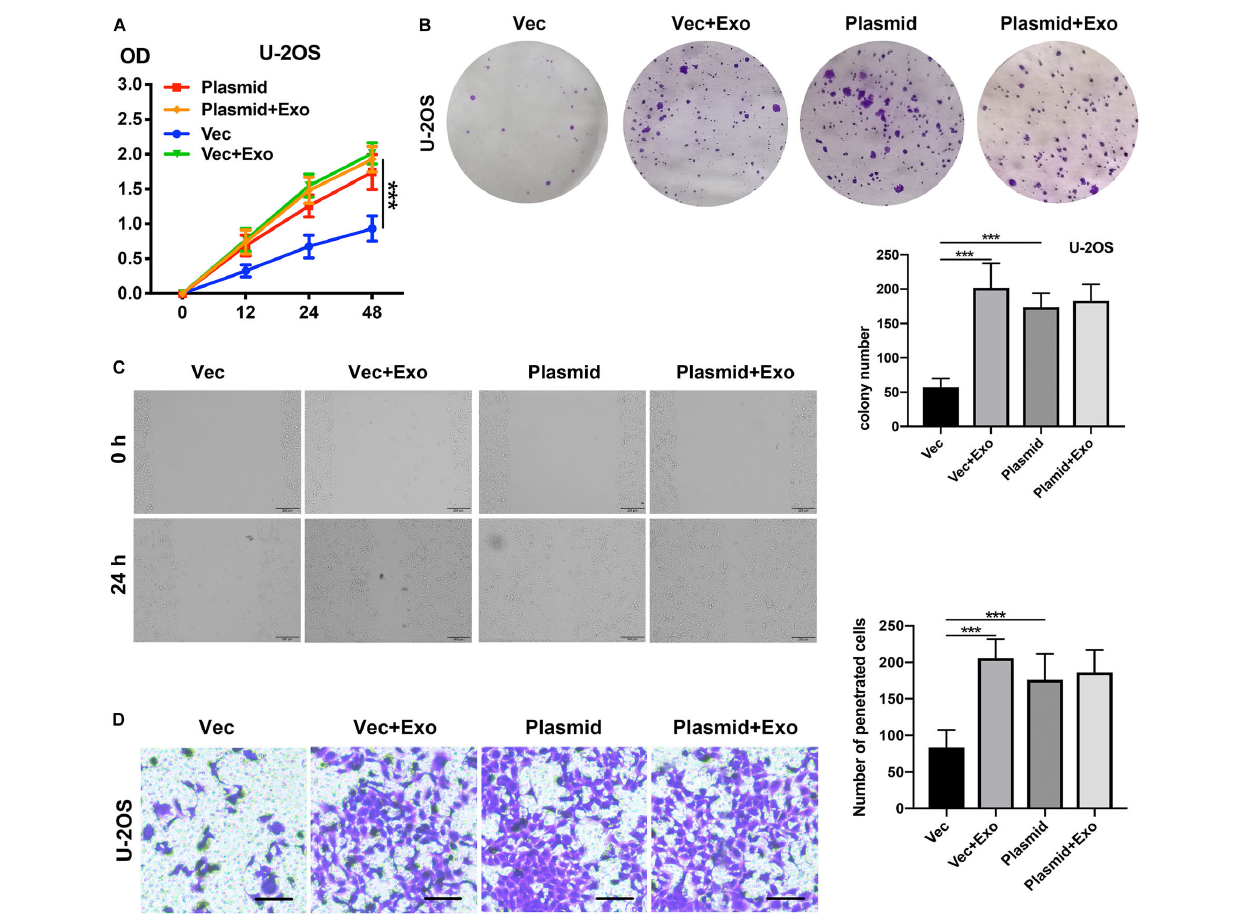
FIGURE 6 | COLGALT2 overexpression increases U-2OS cell invasion, migration, and proliferation. (A) The effects of COLGALT2 overexpression on the proliferation of U-2OS cells were evaluated using a CCK8 assay. Data collected from the three respective experiments are displayed. (B) Colony numbers (right panel) and representative images of colony formation (left panel) after COLGALT2 overexpression in U-2OS cells. (C) After COLGALT2 overexpression in U-2OS cells, representative images of wound areas at 24 h and U-2OS cells cultured alone as controls. (D) Representative images and statistical analysis of invaded cells in the Transwell invasion assay. All values are presented as the means ± SDs of three independent experiments. *** P <